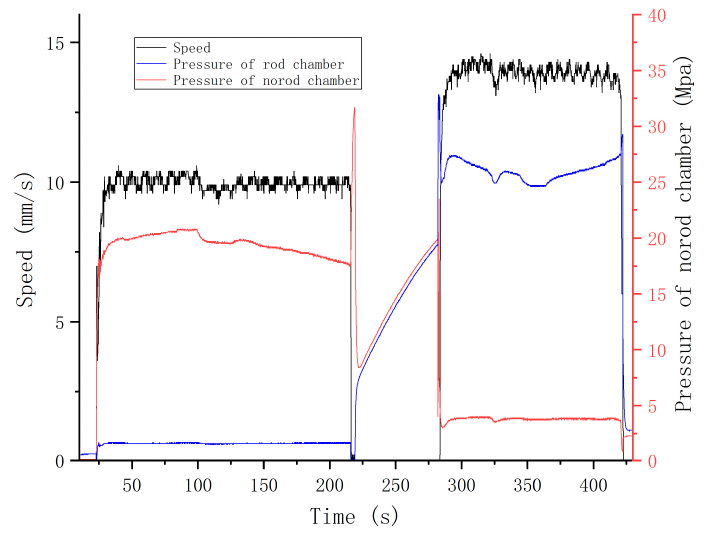
Figure 20. Step response experiment results of cylinder #2 using PID.